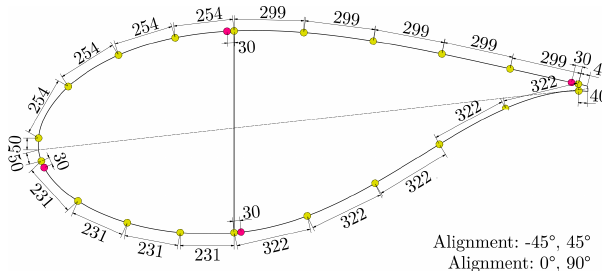
Wind Energ. Sci., 7, 105–127, 2022